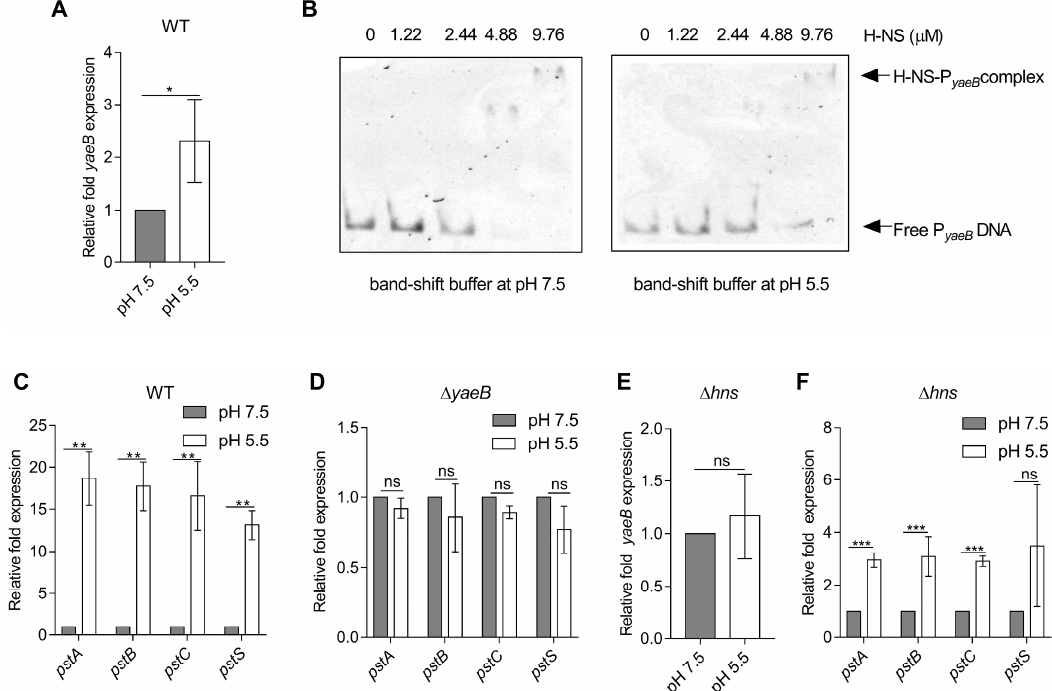
Figure 5. Acidic pH induced yaeB and pstSCAB gene expression. S . Typhimurium WT strain was cultured in N-minimal medium at pH 5.5 or 7.5 to the stationary phase. Fold changes in yaeB ( A ), pstA , pstB , pstC , and pstS ( C ) expression at pH 5.5 relative to that at pH 7.5 are presented. ( B ) EMSAs of yaeB promoter DNA fragments with purified H-NS protein (0, 1.22, 2.44, 4.88, and 9.76 µ M) in band-shift bu ff er at pH 7.5 or pH 5.5. ( D ) Fold changes in pstA , pstB , pstC , and pstS expression at pH 5.5 relative to that at pH 7.5 after culture of the yaeB mutant strain in N-minimal medium to the stationary phase are presented. Fold changes in yaeB ( E ), pstA , pstB , pstC , and pstS ( F ) expression at pH 5.5 relative to that at pH 7.5 after culture of the hns mutant strain in N-minimal medium to the stationary phase are presented. Student’s t -tests were used to calculate P values. * P < 0.05; ** P < 0.01; *** P < 0.001; ns, not